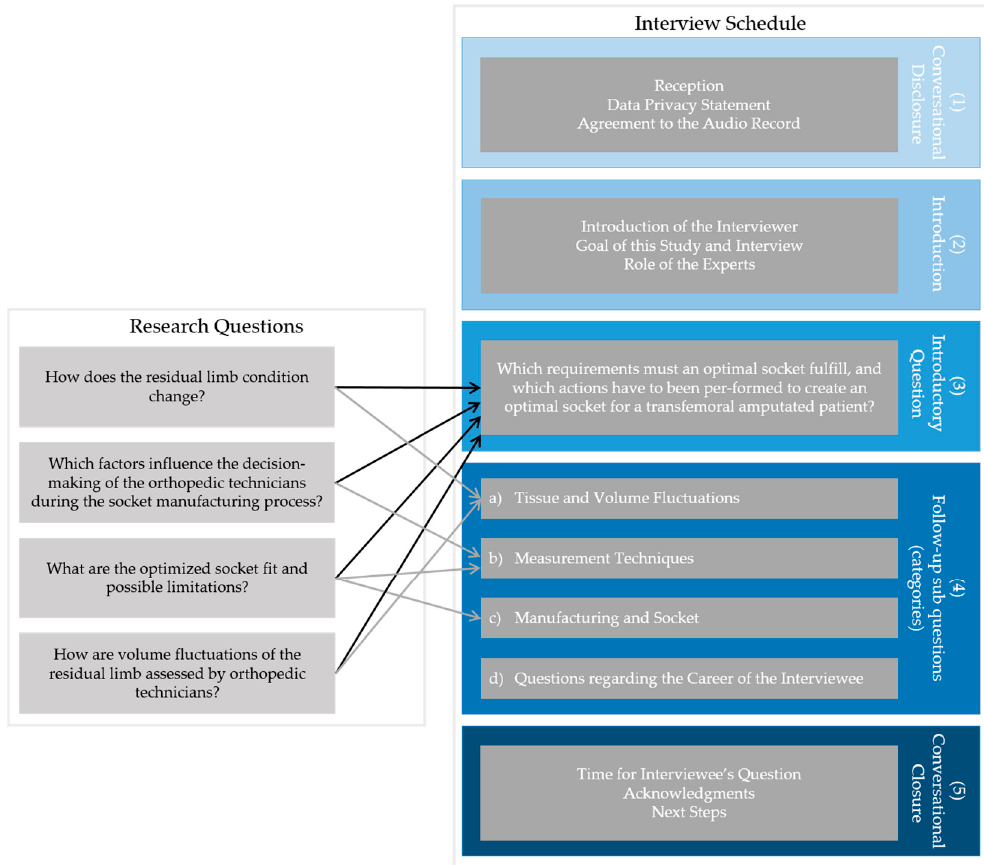
Figure 7. Research design: research questions vs. introductory question and categories of follow-up sub questions.